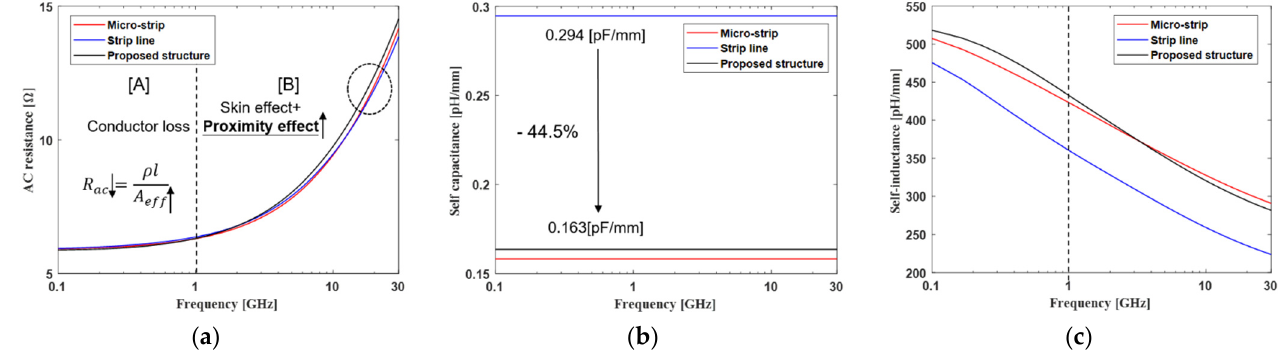
Figure 10. RLC component of the proposed channel structure: ( a ) AC resistance, ( b ) self-capacitance, and ( c ) self-inductance.